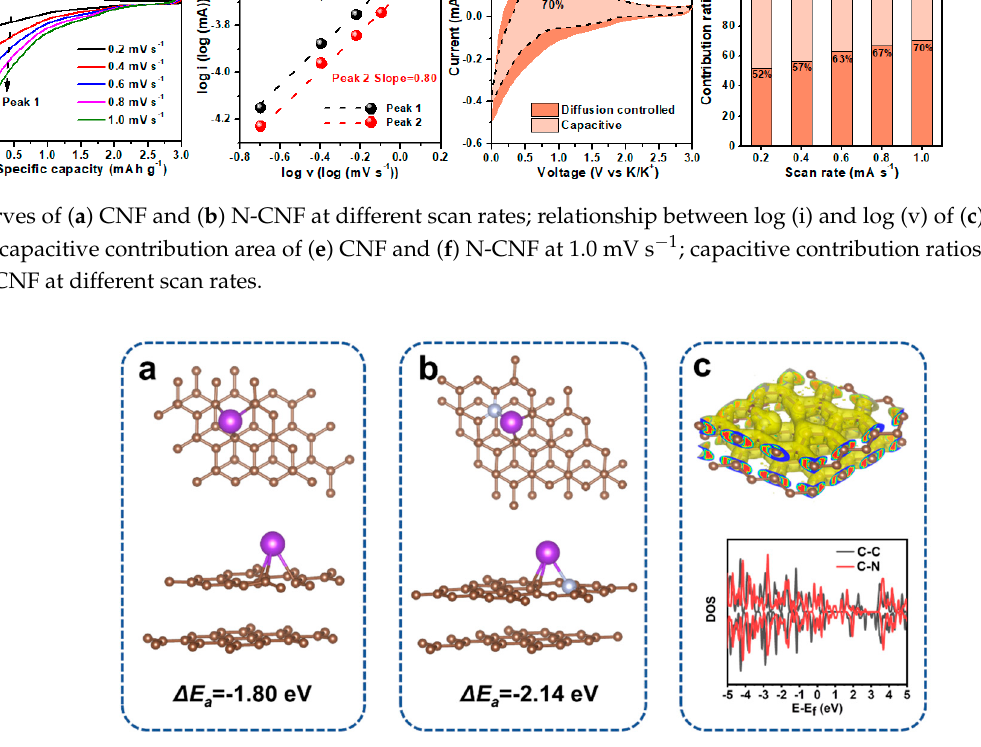
Figure 6. DFT calculations of the adsorption models and the electrolyte structures: ( a ) the models and energy of C after K+ absorption, ( b ) the models and energy of N–C after K+ absorption, ( c ) the electronic localization function of N–C and the density of states (DOS) for the C–C model and the C–N model.